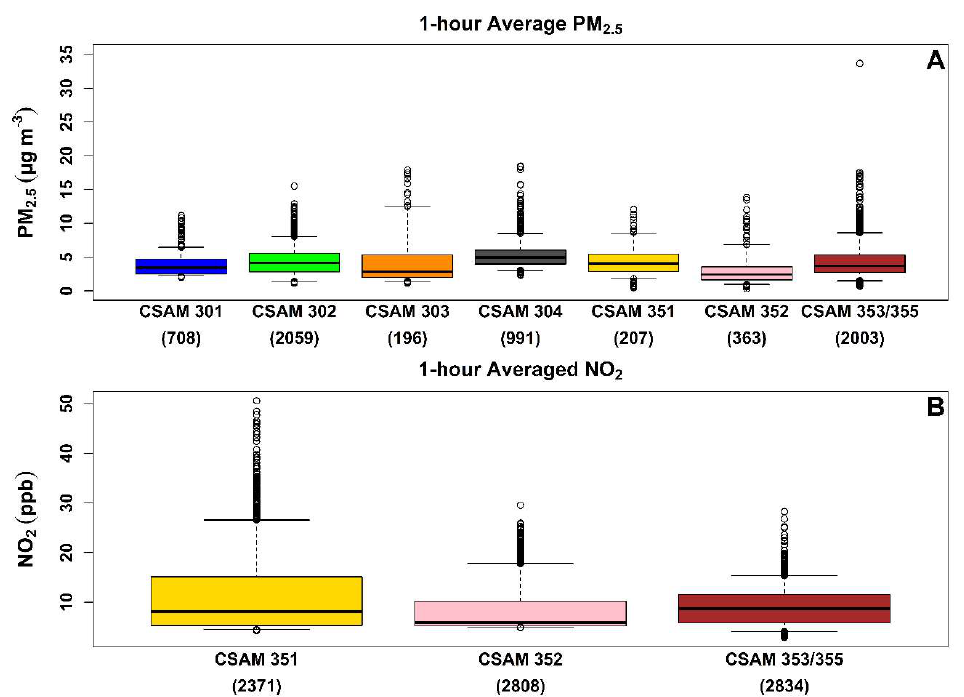
Figure 3. The 1 h average PM 2.5 ( A ) and NO 2 ( B ) concentrations collected during the deployment for each CSAM location. The box represents the interquartile range of 25th and 75th percentile and the whiskers indicate the 5th and 95th percentile. The horizontal line in each box is the median concentration. The x-axis displays the number of 1 h average data points measured at each CSAM location.